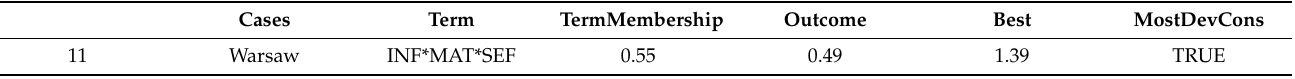
Table 6. Deviant Consistency Cases